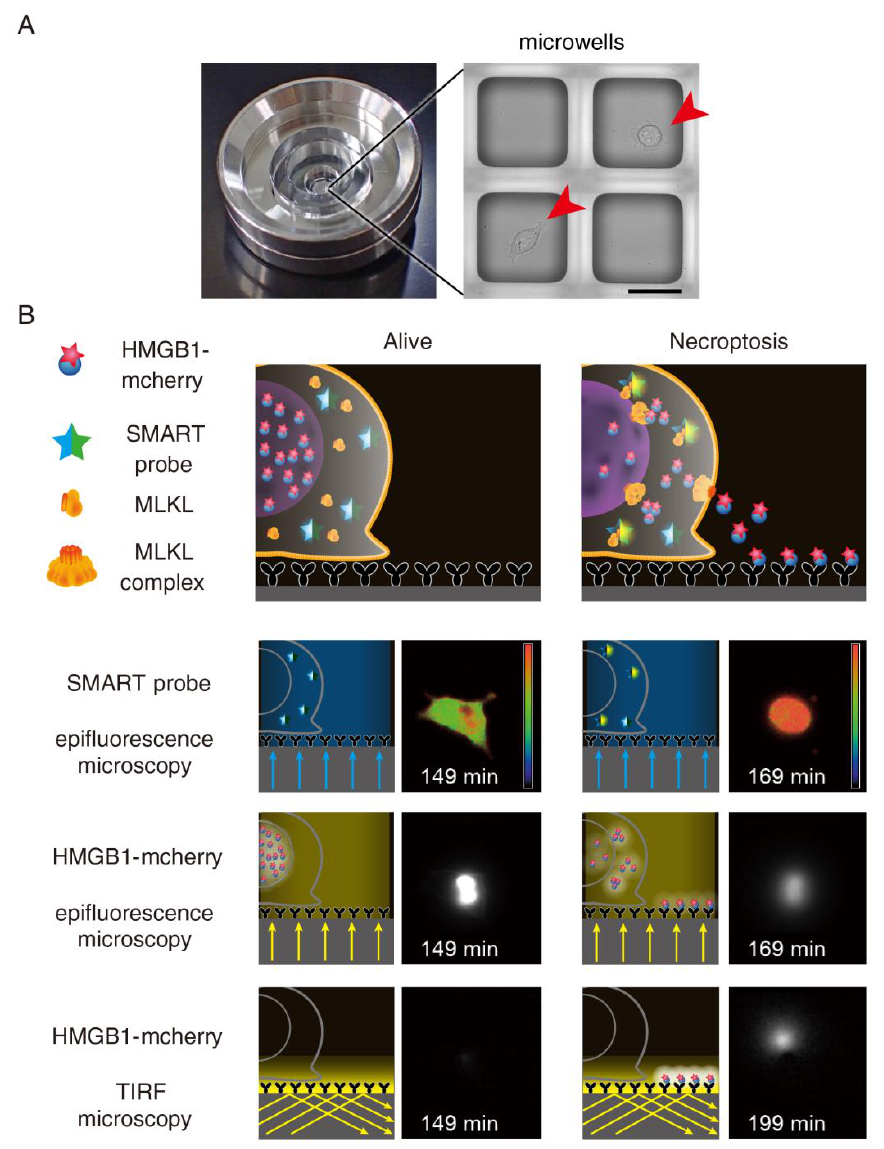
FIGURE 2: Detection of the release of HMGB1-mCherry using TIRF microscopy. (A) A single chamber well is composed of approximately 1,000 sub-nanolitre-sized mi- crowells with 80  m square in size where a single cell is seeded onto one microwell. Scale bars indicate 50  m. Arrowheads indicate indi- vidual cell. (B) LCI-S monitors an increase in the FRET/CFP ratio of SMART, HMGB1-mCherry signals in the nucleus by epifluorescence microscopy, and released HMGB1- mCherry by TIRF-M. Microwells were precoated with anti-RFP anti- body, and released HMGB1- mCherry was rapidly captured by anti-RFP antibody and was detect- ed by TIRF-M. L929 cells were un- treated (Alive) or treated with TNF and zVAD-fmk to induce necropto- sis (Necroptosis). Fluorescent sig- nals were analyzed at every 2 min and representative images of live and necroptotic cells are